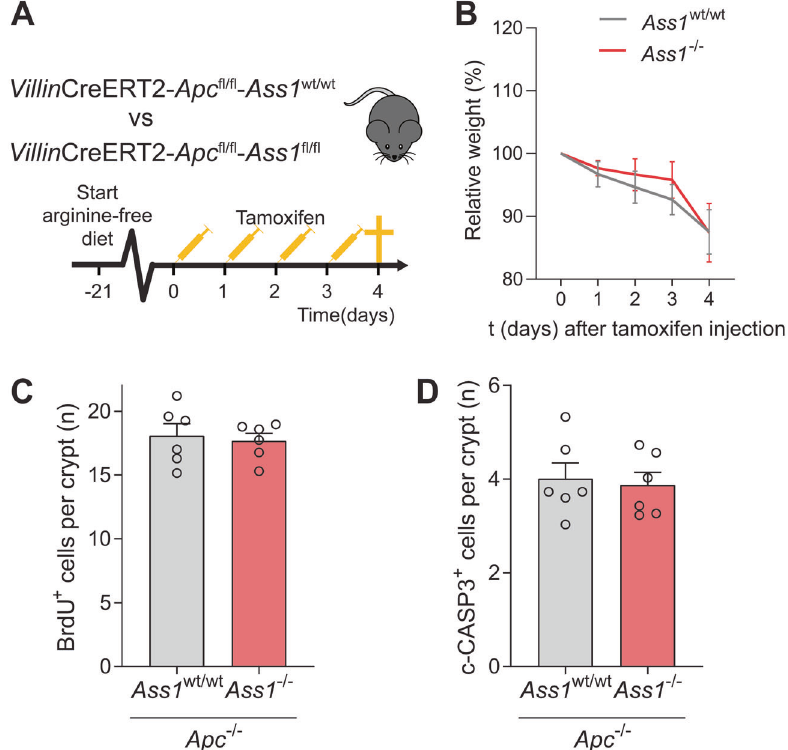
Fig. 7 Ass1 knockout in the intestinal epithelium does not affect Apc- mediated hyperproliferation in mice fed an arginine-free diet. A Schematic overview of the mouse model. B Relative weight compared to start tamoxifen injections. C Amount of BrdU-positive cells per crypt in the small intestine. D Amount of cleaved caspase-3-positive cells per crypt in the small